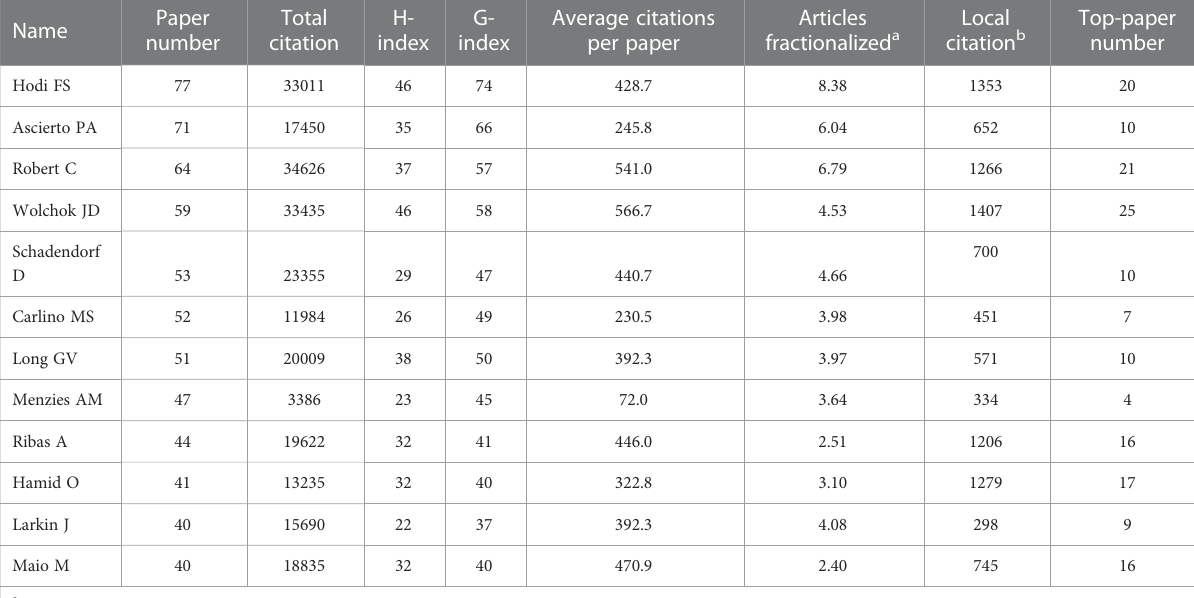
TABLE 6 Authors of at least 40 papers in melanoma immunotherapy between 2010 and 2022.